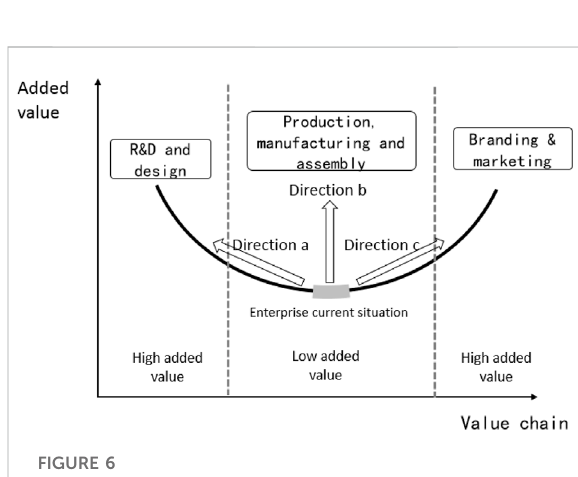
FIGURE 6 Generaltransformationandupgradingpathofmanufacturing enterprises.